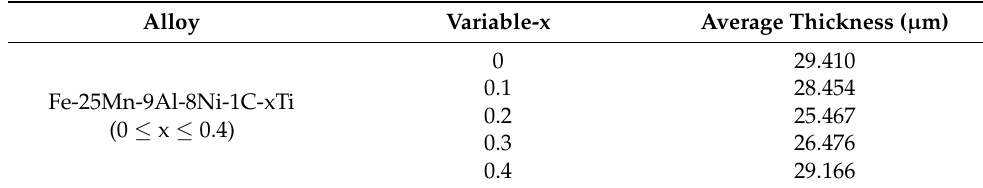
Table 4. The average thickness of oxidation layer of alloy with 600 ◦ C insulation for 200